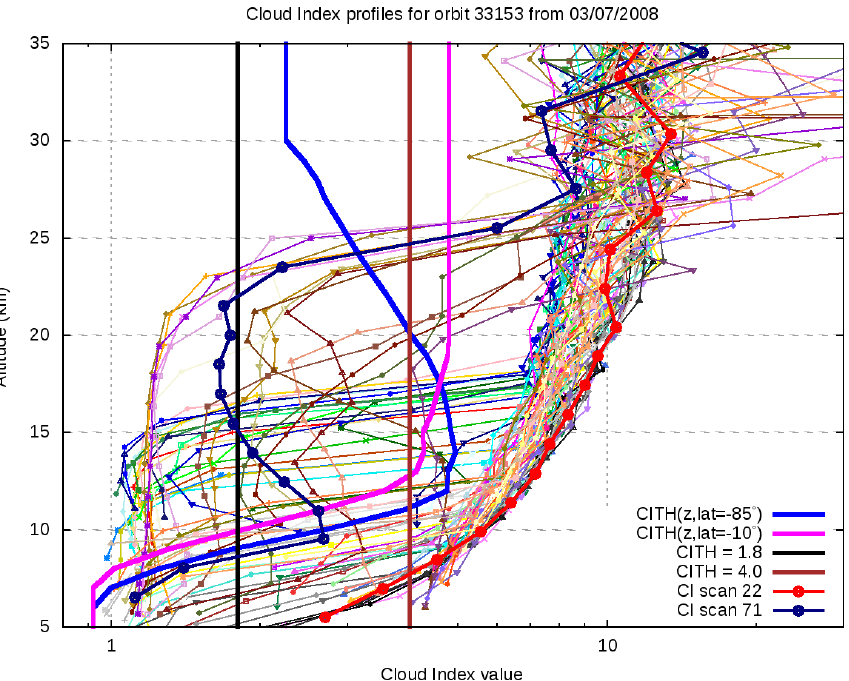
Figure 18. CI profiles computed for all limb scans of orbit 33153 from 3 July 2008. The thicker lines with dots, dark blue and red, respectively, show two selected scans at latitudes 61 ◦ S (polar winter), scan number 71, and 63 ◦ N (polar summer), scan number 22. The water vapour profiles retrieved from these two scans are shown in Fig. 19.